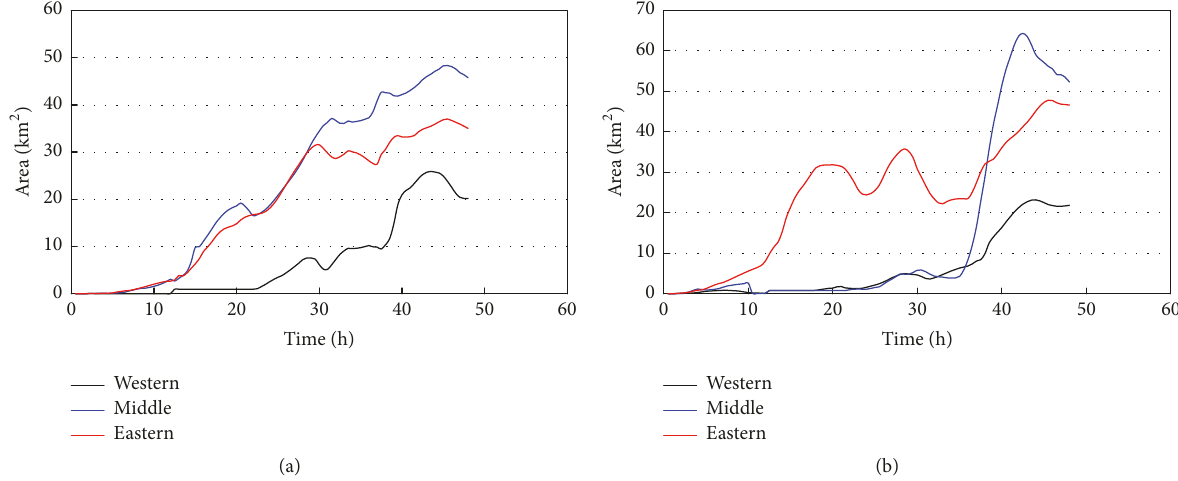
Figure 22: Area of instantaneous (a) and continuous (b) oil spills versus time in different spill locations (black line for the western spill location, blue line for the middle spill location, and red line for the eastern spill location) under the influence of south